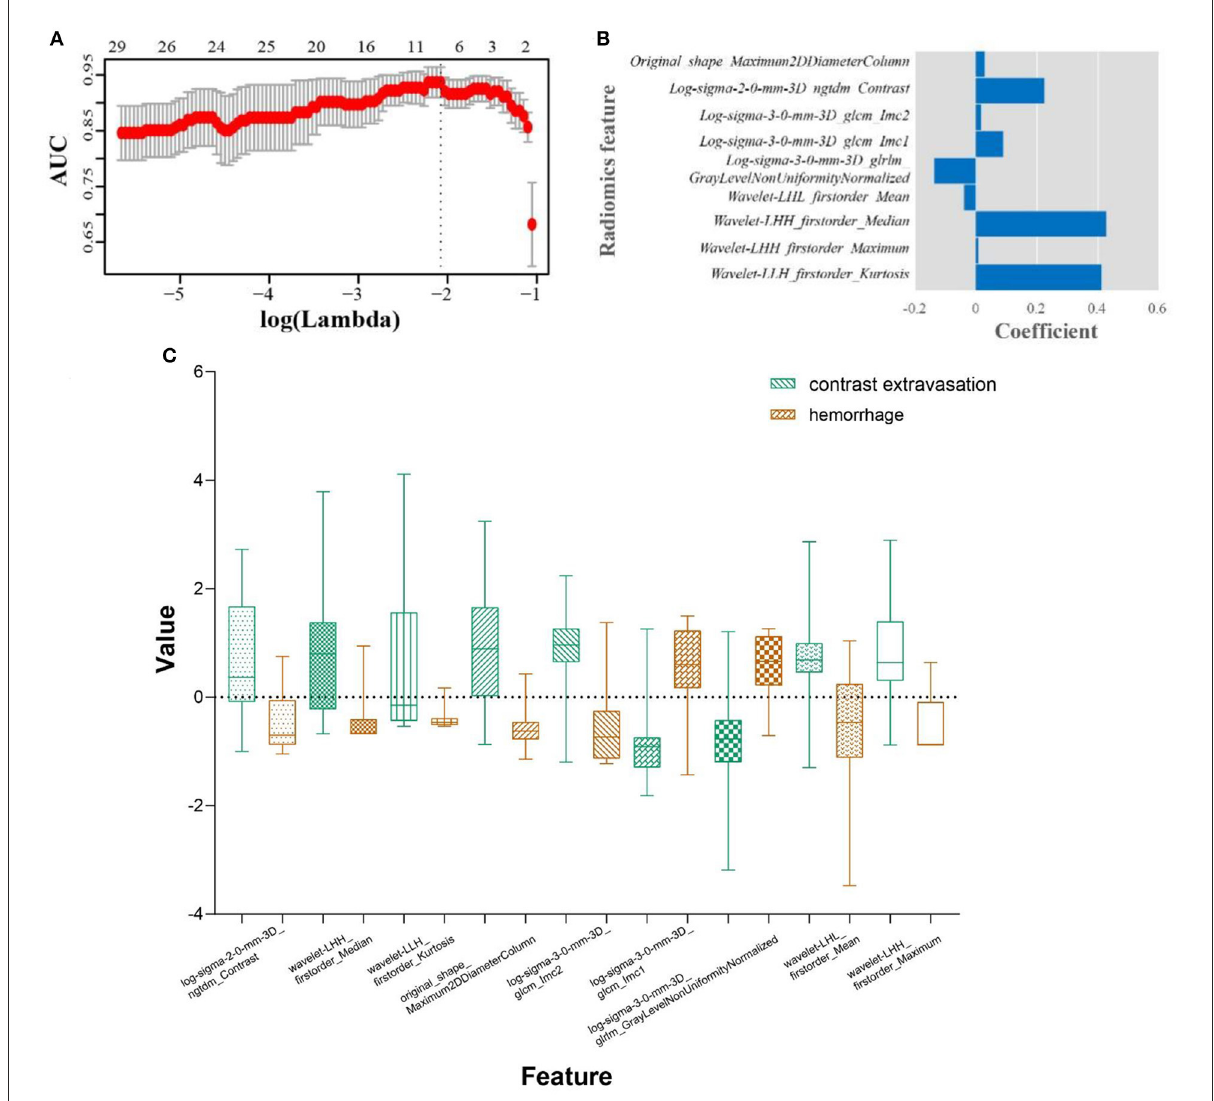
FIGURE2 Radiomics feature selection using the least absolute shrinkage and selection operator (LASSO) regression algorithm. (A) Tuning parameter ( λ ) selection in the LASSO used 10-fold cross-validation via minimum criteria. The dotted vertical line was drawn at the optimal values using the minimum criteria. A log ( λ ) value of − 2.079 was opted. (B) Boxplots for LASSO coefficient of the selected nine radiomic features. (C) Boxplots for the selected features between hemorrhage and contrast extravasation